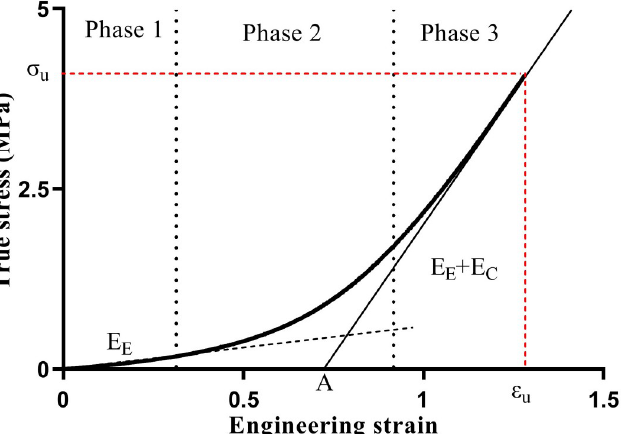
Fig 3. The three presumed phases of the aortic elastic response and the relationship between the elastin fiber modulus, collagen fiber modulus and stress-strain curve.